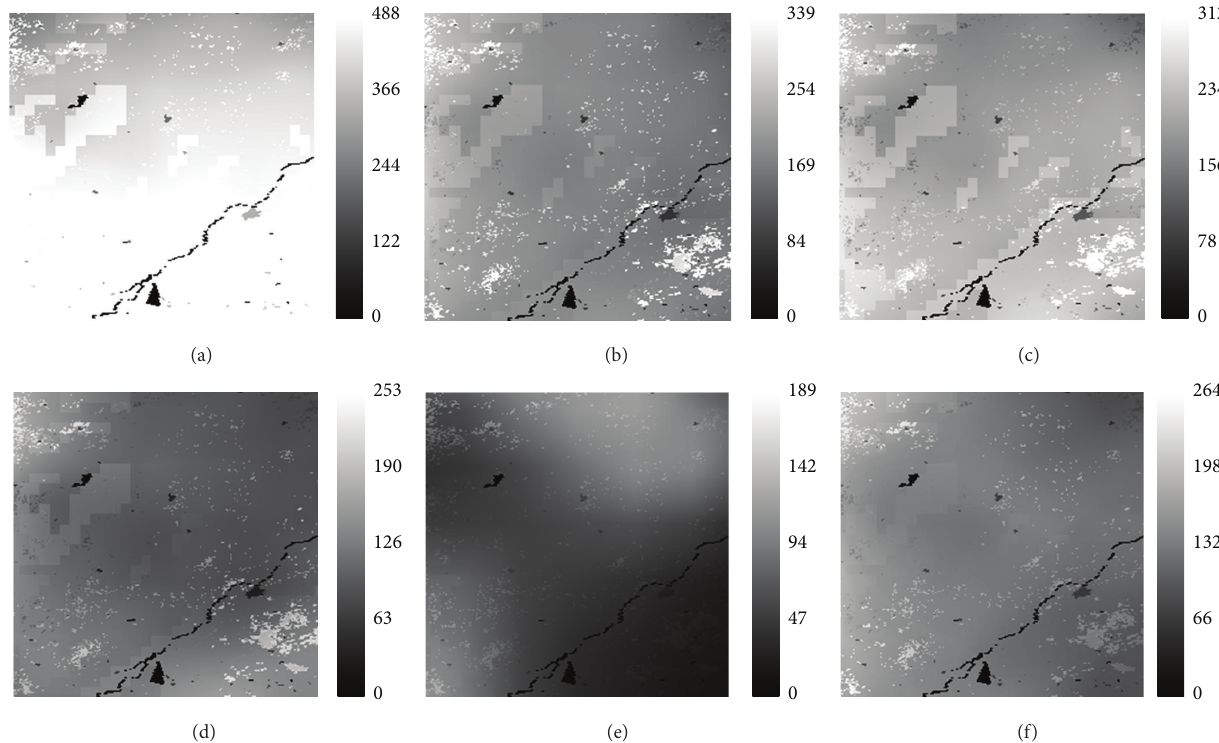
Figure 4: The EPs of the Noah model at 15:00 solar time closest to the available MDREs in Figure 3. (a) The EP on May 2, 2005; (b) the EP on May 7, 2005; (c) the EP on May 14, 2005; (d) the EP on May 19, 2005; (e) the EP on May 25, 2005; (f) the EP on May 31,